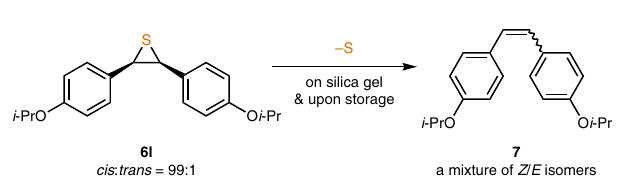
Fig. 4 | Instability of electron-rich thiirane. Non-stereospeci fi c, spontaneous desulfurization of p -alkoxy- cis